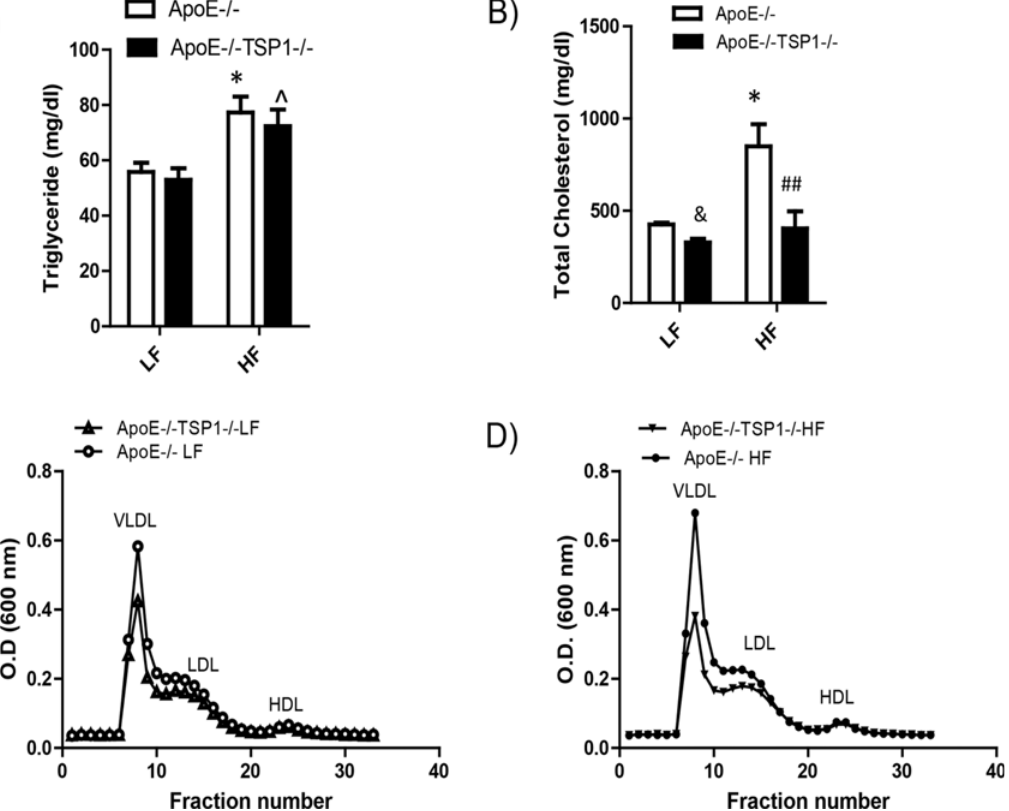
Fig 4. Effect of TSP1 deficiency on plasma triglyceride levels, total cholesterol levels, and cholesterol lipoprotein distribution under either LF or HF feeding conditions. Male ApoE-/-TSP1-/- mice and ApoE-/-mice were fed LF or HF diet for 16 weeks. A). Plasma triglyceride levels were measured. B). Plasma total cholesterol levels were measured. C) and D) cholesterol lipoprotein distribution was analyzed by FPLC. Data are represented as mean ± SE (n = 6 mice/group). & P < 0.05 vs, LF ApoE-/-; * P < 0.05 vs. LF ApoE-/-. ## P < 0.01 vs. HF ApoE-/-. ^ p < 0.05 vs. LF ApoE-/-TSP1-/-